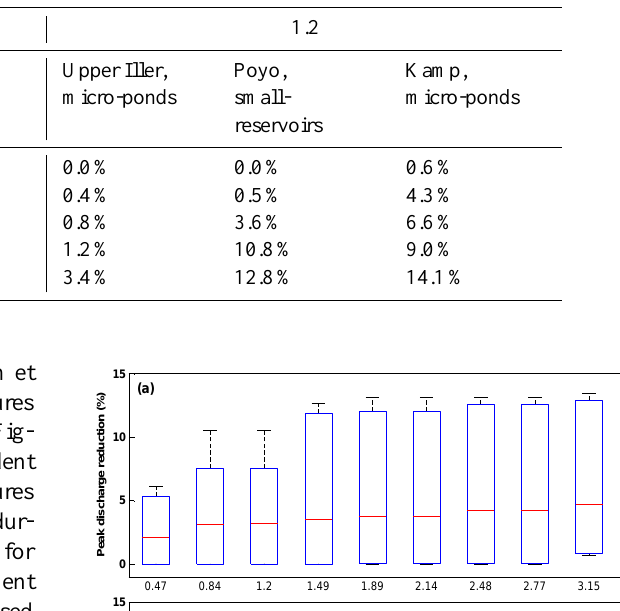
Table 8. Peak discharge reduction quartiles for the retention elements in the landscape scenarios.